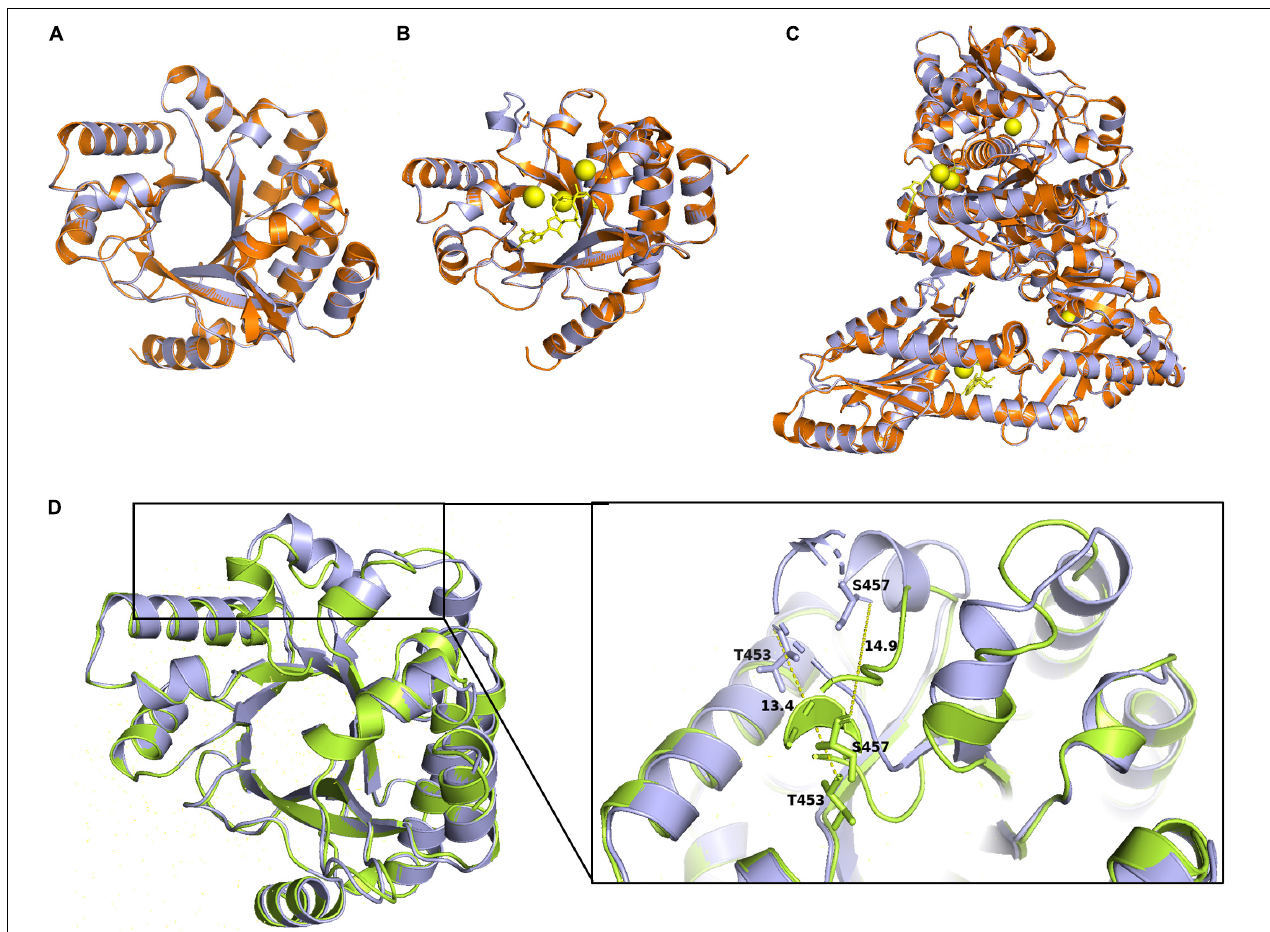
FIGURE 6 | Homology models of the ProE with PA3825 and RmcA. Superimposition of the wild type ProE models with templates of 4y9m (PA3825-Apo), RMSD = 0.064 (214 to 214 atoms) (A) , and 4y9p (PA3825-Ca 2 + and c-di-GMP), RMSD = 0.04 (213 to 213 atoms) (B) , and 5m3C (RmcA-Ca 2 + -GTP), RMSD = 0.190 (721 to 721 atoms) (C) . ProE and templates are shown in lightblue and orange cartoons, respectively. C-di-GMP and GTP are shown as yellow sticks, calcium ions are shown in yellow spheres. (D) Superposition of Apo-ProE and ligand-bound ProE models reveals conformational changes due to ligand interaction. Apo-ProE and ligand-bound ProE are shown in lightblue and lime cartoons, respectively. The number represents the distance between residues